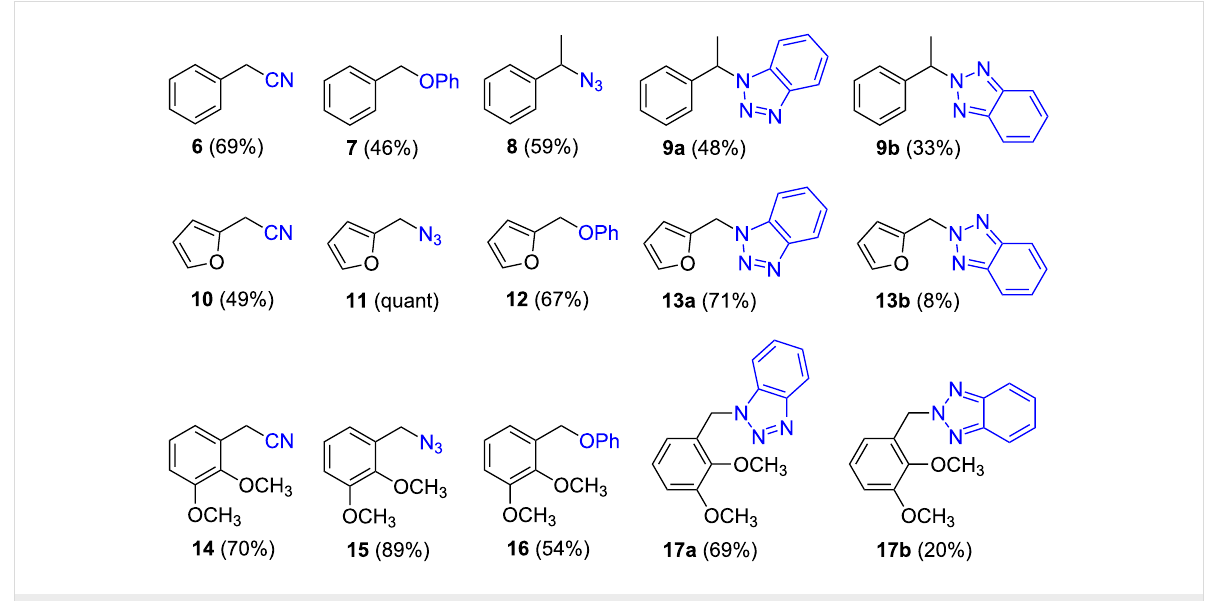
Figure 3: Products from the nucleophilic substitution reactions.